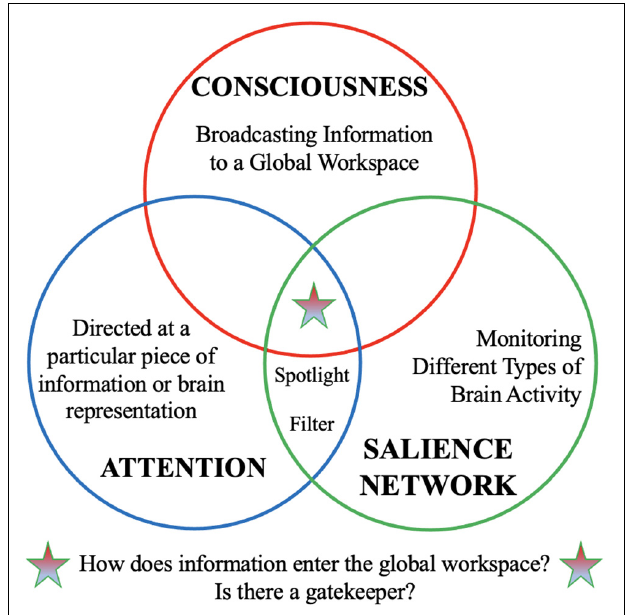
FIGURE 1 | Conceptual overlap between “attention,” “consciousness,” and “salience network.” The salience network is a functional network that is thought to play an important role in filtering important information from “noise” and acts as the brain’s spotlight to tune into important information. We use similar analogies of a “filter” and “spotlight” to describe attentional processes. Meanwhile, “consciousness” is associated with broadcasting information widely to global brain workspace. This conceptual analysis raises interesting questions: How does information enters the global workspace for broadcasting to consciousness? Is there a gatekeeper that regulates information entering the global